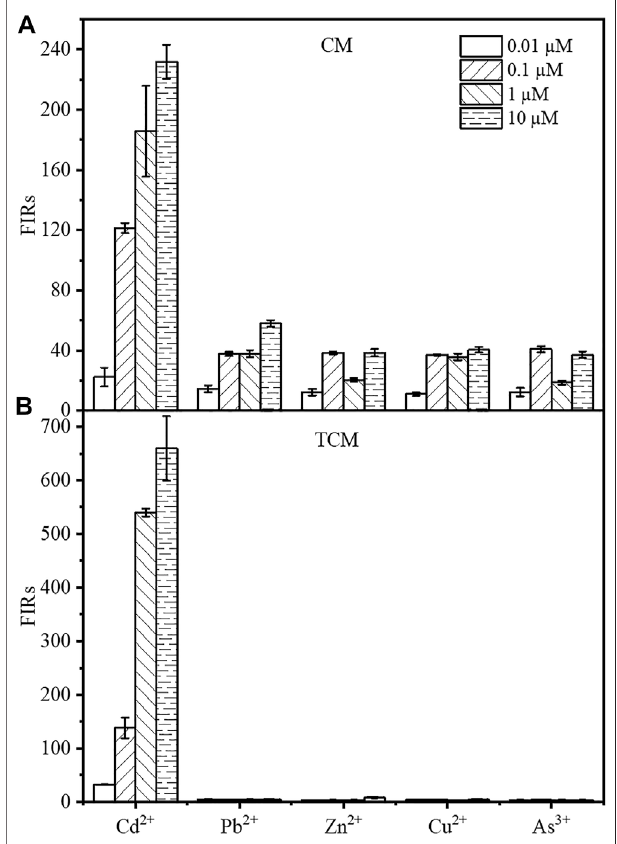
FIGURE 5 | The Cd 2+ speci fi city of the biosensor CM without negative feedback (A) and the negative feedback ampli fi er biosensor TCM (B) . The fl uorescence intensity of the biosensor was measured by incubating the cells for 8 h in the presence of 0.01, 0.1, 1, or 10 µM Cd 2+ , respectively. The error bars represent standard deviations from triplicate